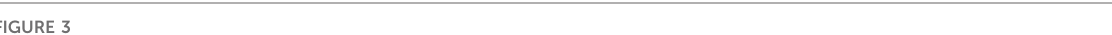
FIGURE 3 antibodies to visualize CMs, ECs, and CFs, respectively, and nuclei were counterstained with DAPI; representative images are displayed for each grouponD7,D30,andD60. (C,D) CM,EC,andCFoccupancywerequanti fi edasthepercentageoftotalsurfaceareathatwaspositiveforexpression of the corresponding marker protein and summarized (C) for C1, C3, and C4 on D7 and (D) for C4 on D7, D30, and D60. (E) Representative sections from a C4 spheroid on D60 are displayed at high magni fi cation to demonstrate the presence of elongated ECs. (* p < 0.05, ** p < 0.01, *** p < 0.001; n > 6 per